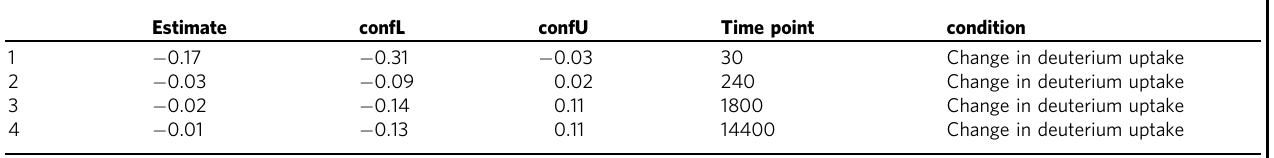
Table 1 Difference between deuterum incoperation for peptide DIKDVGVDNAGAKAGLTF in the 10% and 15% structural variant